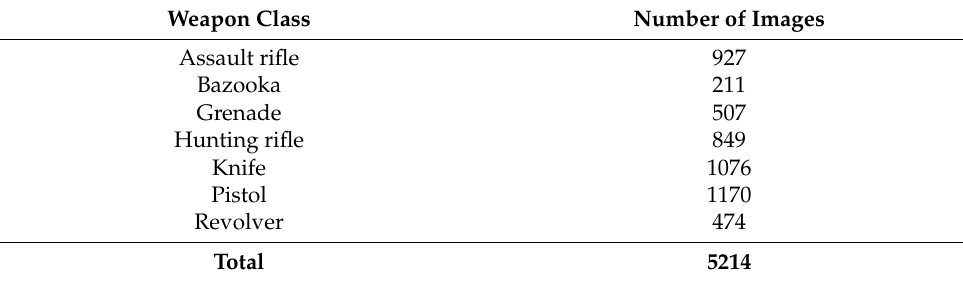
Table 1. Weapon dataset classes and numbers of